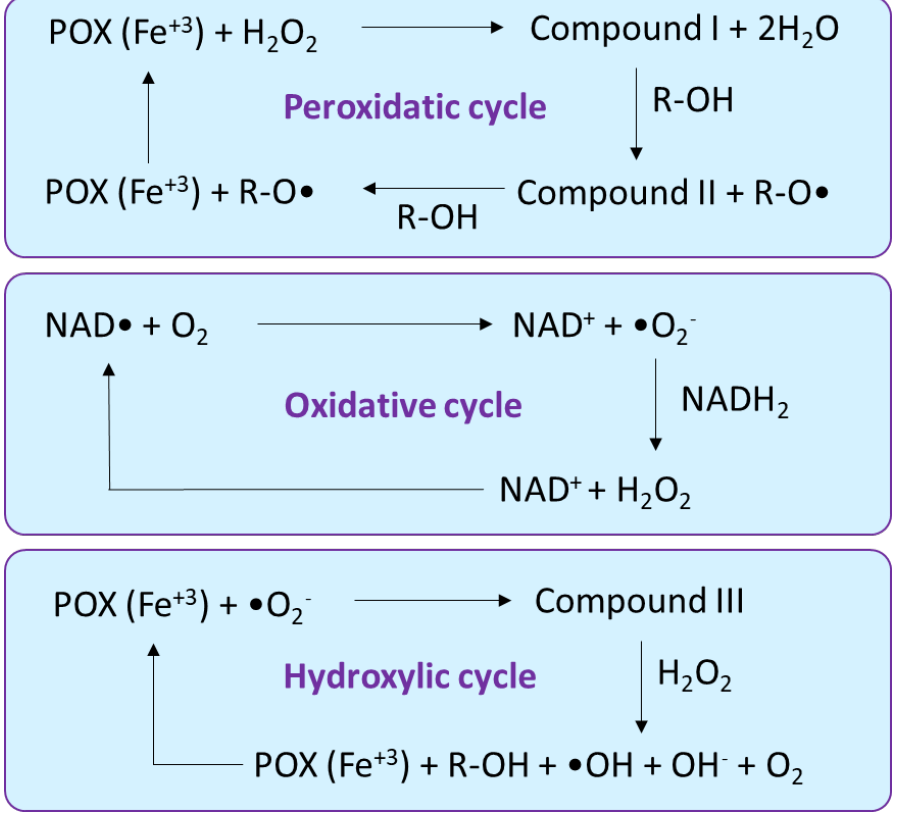
Figure 3. Different reaction cycles catalysed by peroxidase (POX) as reported in in vitro studies. R = any phenolic compound.